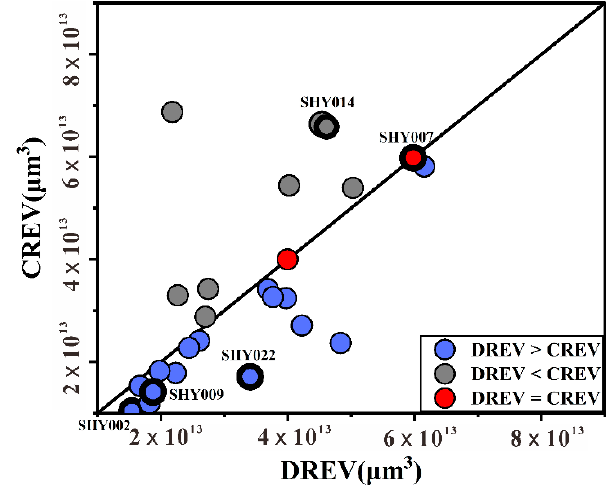
Figure 14. Cross ‐ plot of DREV versus CREV. Figure 14. Cross-plot of DREV versus CREV.